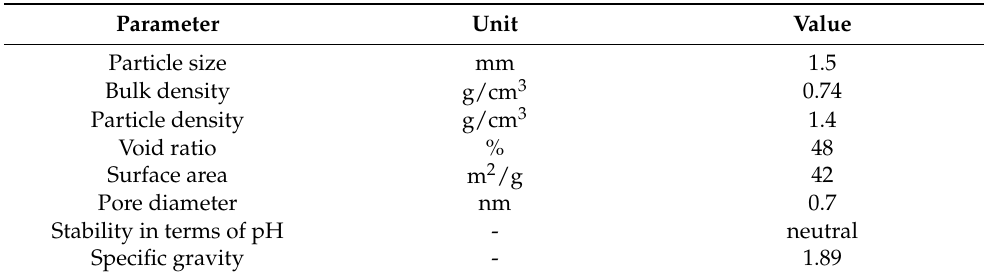
Figure 6. Experimental setup (V f : 0.0035 L/s; pH: 6.4–12.5; T: 22.6–24.4 °C; n = 8). Table 5 provides a summary of the physicochemical characteristics of the zeolite filter materials used in the study. Table 5. Physicochemical properties of the zeolite material used.